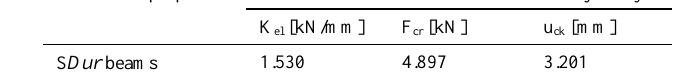
Table 3: Mechanical properties of the elastic behaviour of SDur beams analytically